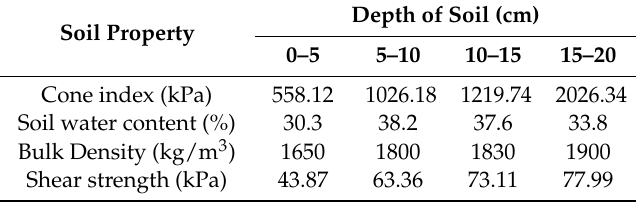
Table 3. Mean soil property according to the depth of the soil.